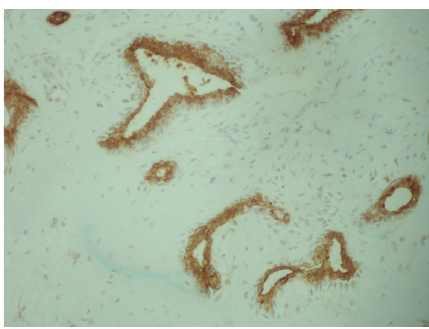
Figure 4: ck7 epithelial cells × 200.